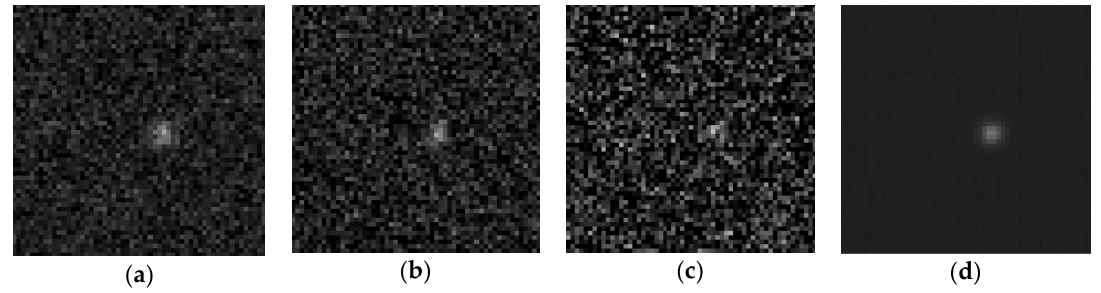
Figure 1. Simulated star images with: ( a ) mild noise, ( b ) moderate noise, ( c ) severe noise, ( d ) ground truth.